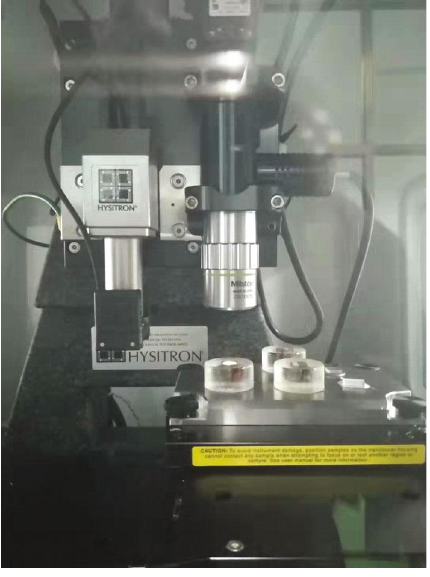
Figure 5: Hysitron T1